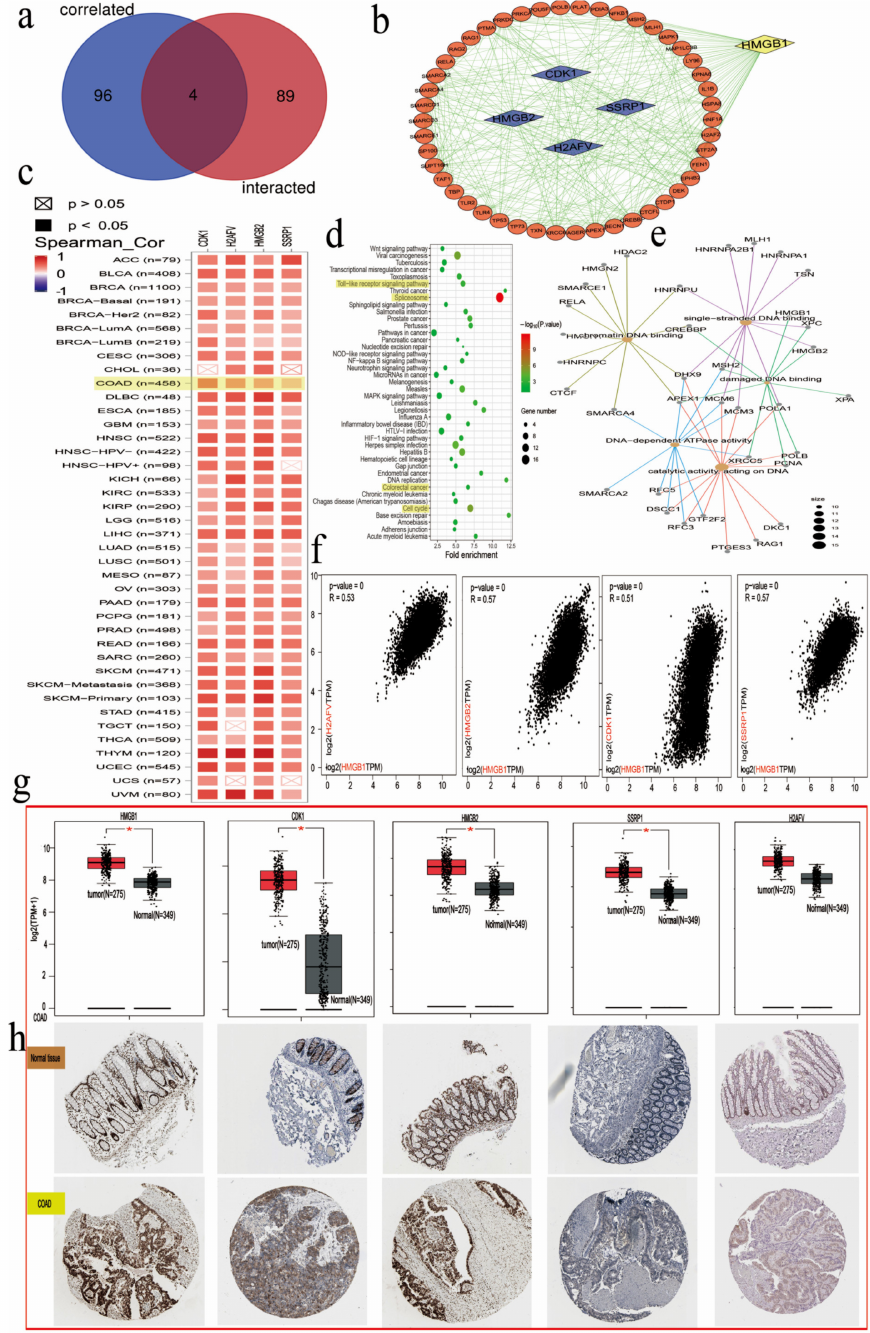
Figure 7. HMGB1-related gene enrichment analysis suggests four correlated genes. ( a ) A Venn